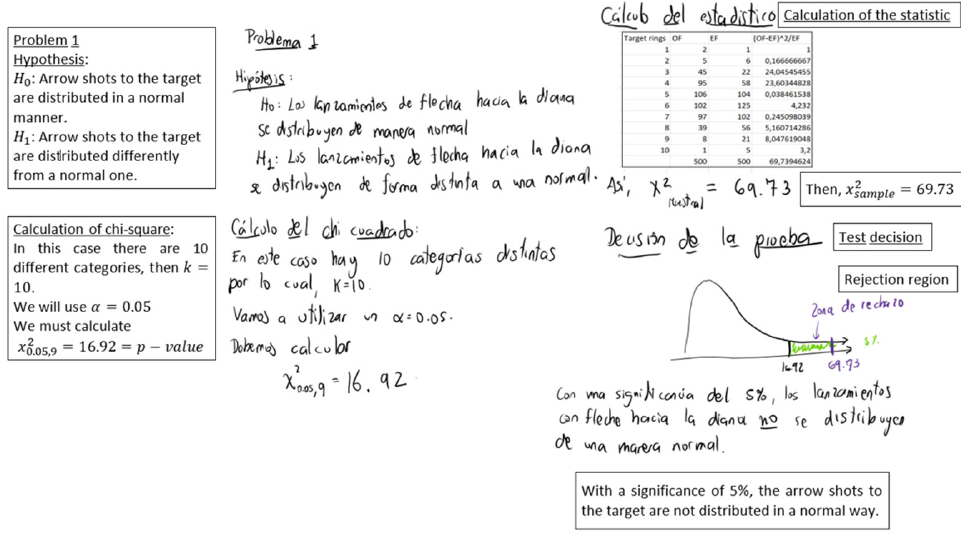
Figure 4. The practice of the prospective Teacher 5 (G2) on Activity 1.